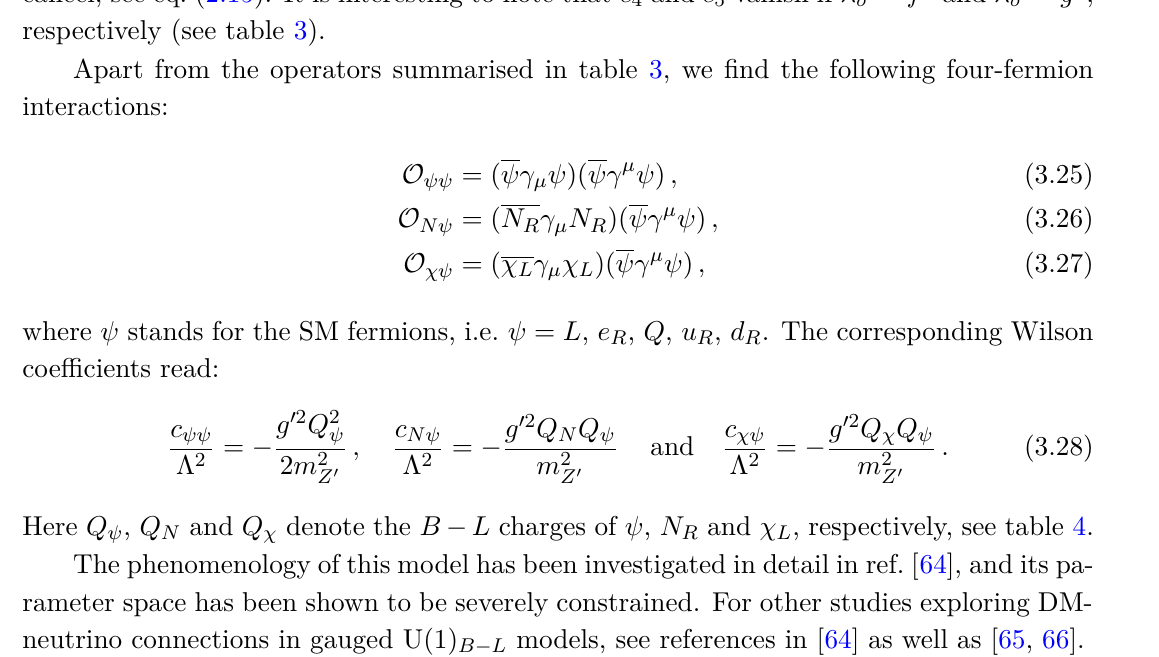
are RH neutrinos, χ R